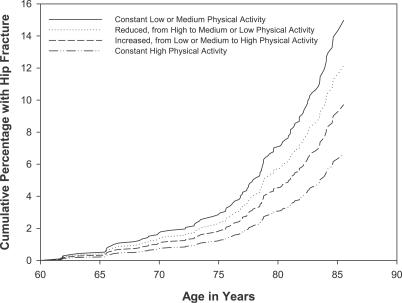
Survival Curves of Hip Fractures after Age 60 y by Change in Physical Activity between 50 and 60 y of AgeSurvival curves are adjusted by reported changes in physical activity at age 70, 77, and 82 y.